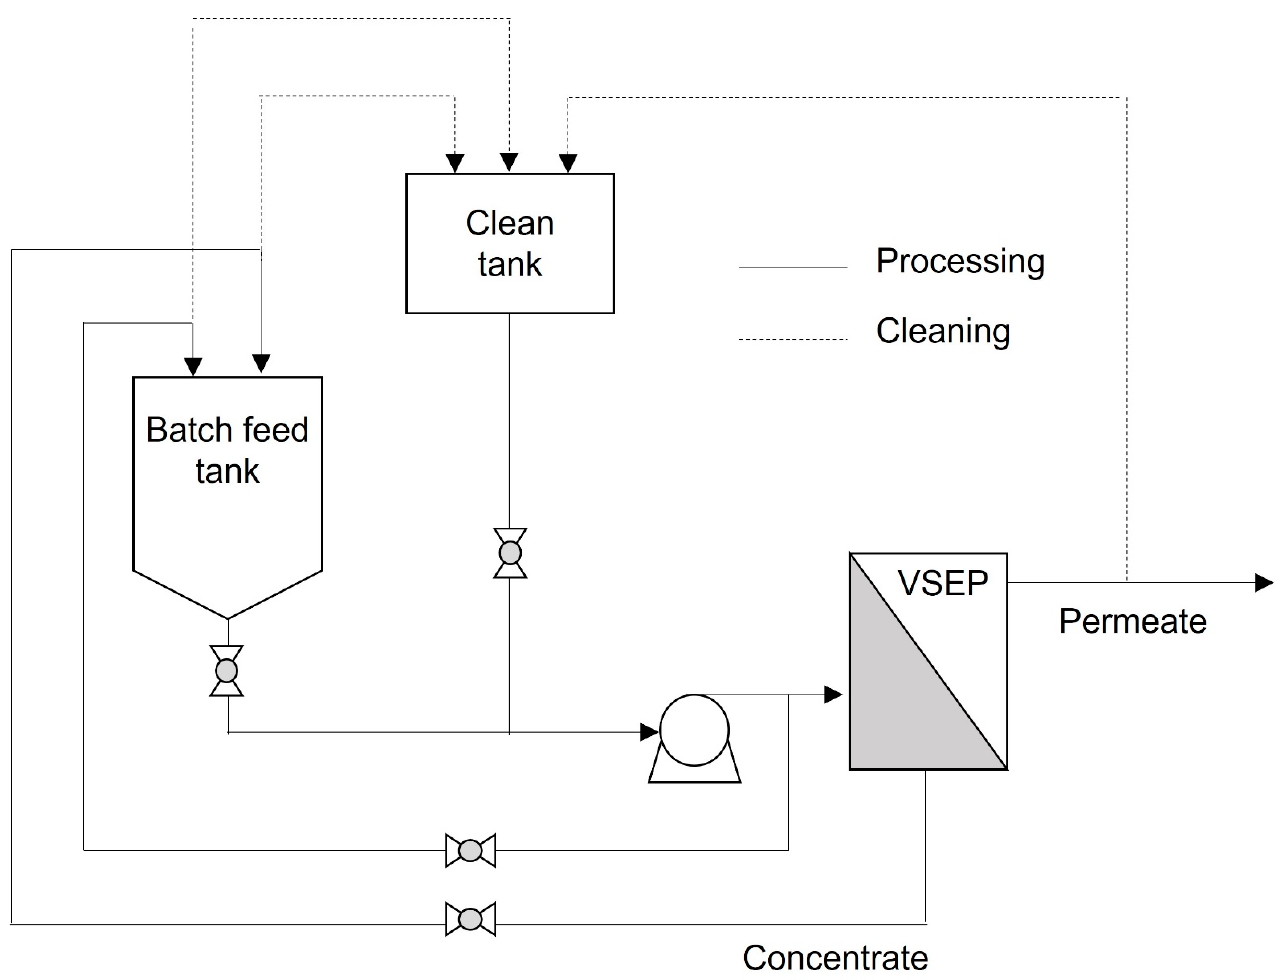
Figure 1. Batch mode pilot testing process flow diagram.